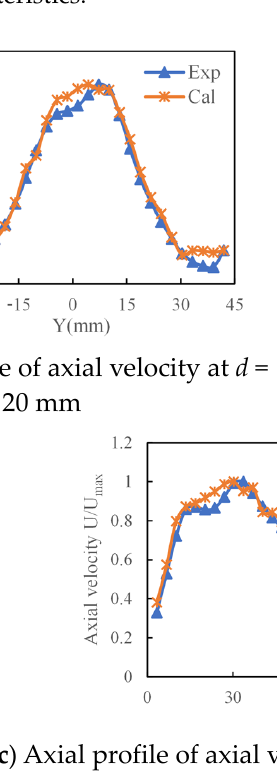
Figure 4. Comparison between numerical and experimental results of axial velocity.